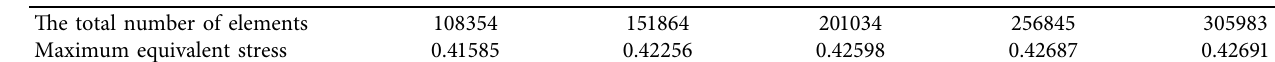
Table 2: Grid independence